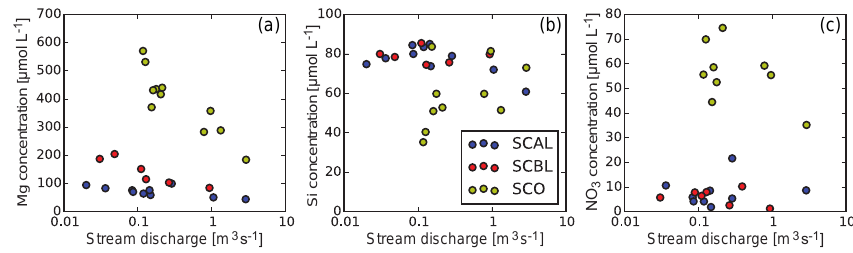
Figure 10. Mg (a) , Si (b) , and nitrate dissolved concentrations (c) (filtered at 0.45µm) and stream discharge measured at three locations on Shavers Creek: above the lake (SCAL, blue), below the lake (SCBL, red), and at the outlet (SCO, yellow) as shown in Fig. 3.